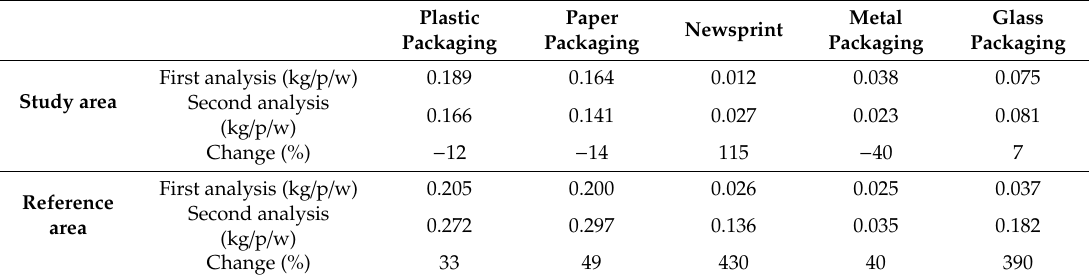
Table 2. The amount of recyclables (kilogram per person and week) in the white bags and changes between the pick analyses for both the study and reference areas.